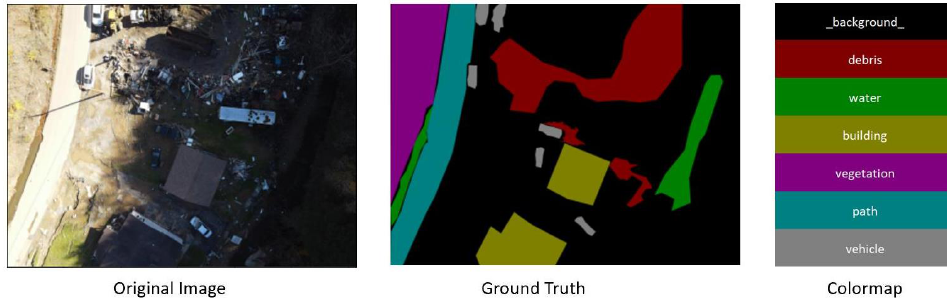
Figure 14. Original Image and Ground